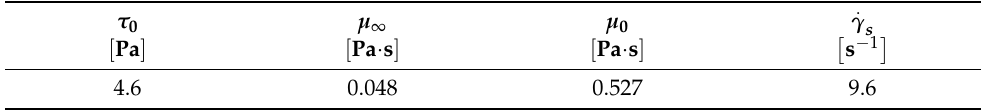
Table 1. Bingham fluid model parameters for an experimental crude